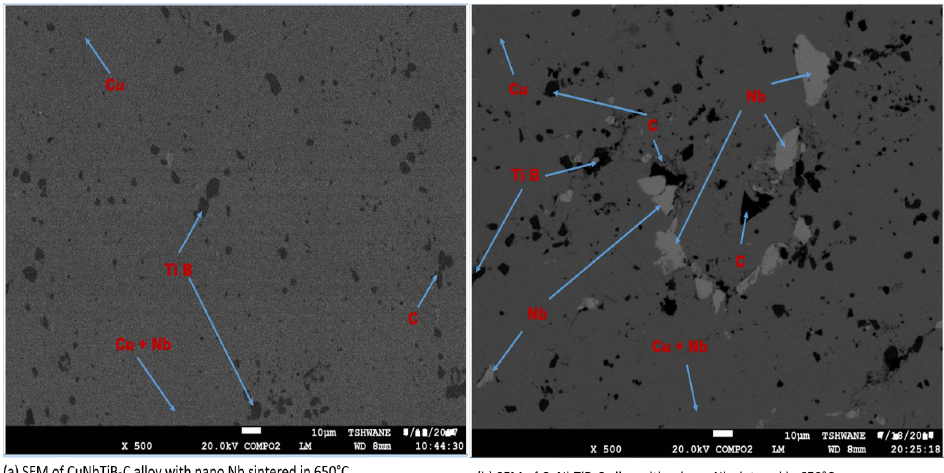
Figure 4. ( a ) and ( b ) compare the SEM of CuNbTiB 2 C alloys with nano and micron both sintered at 650 °C.